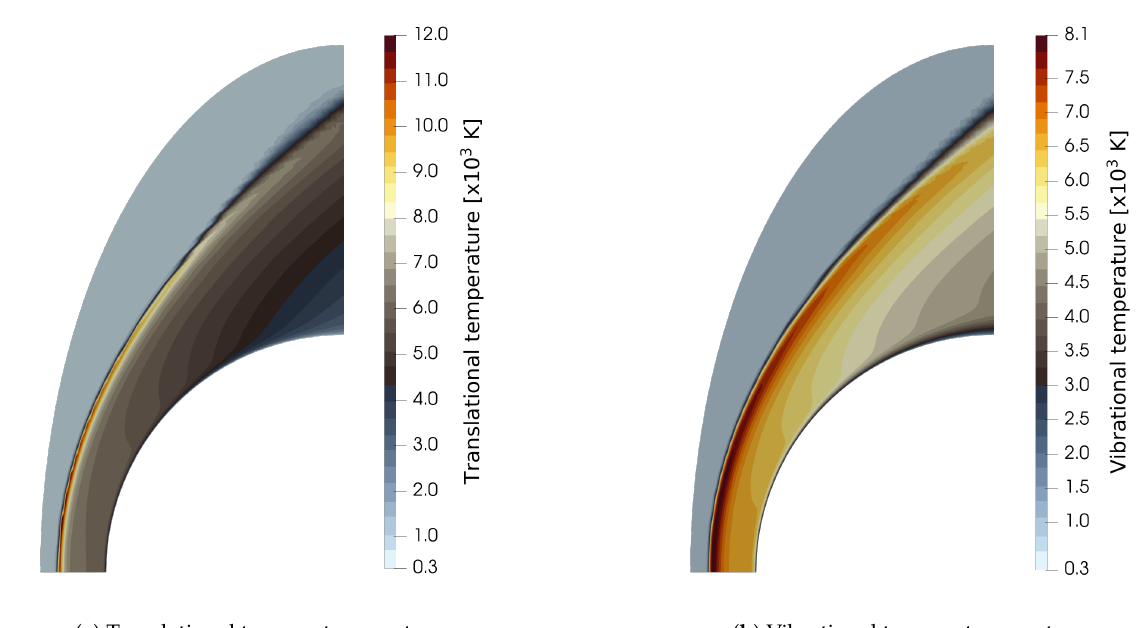
Figure 6. Temperature contours for the HEG cylinder test case.